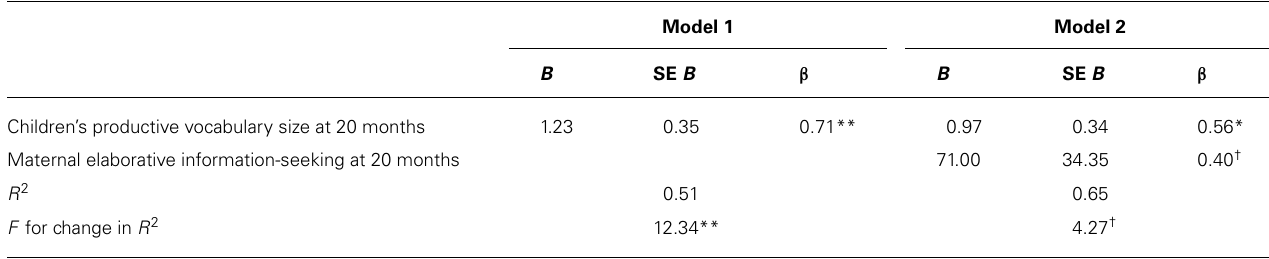
Table 4 | Hierarchical regression analysis on the ability of maternal elaborative information-seeking responses to children’s provision of information about agents at 20 months to predict children’s observed productive vocabulary size at 27 months ( N =